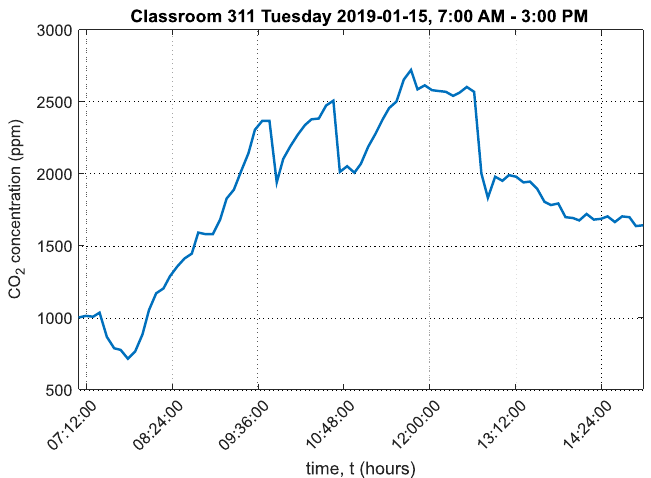
Figure 17. Graph of carbon dioxide concentration in classroom 311, Frenštát pod